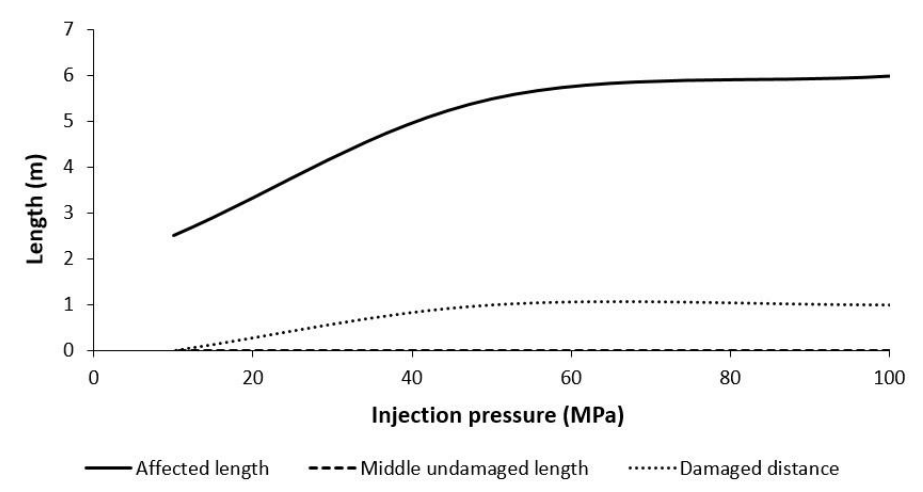
Figure 11. Comparison of numerical models with borehole lengths of 5 m and different injection pressures.